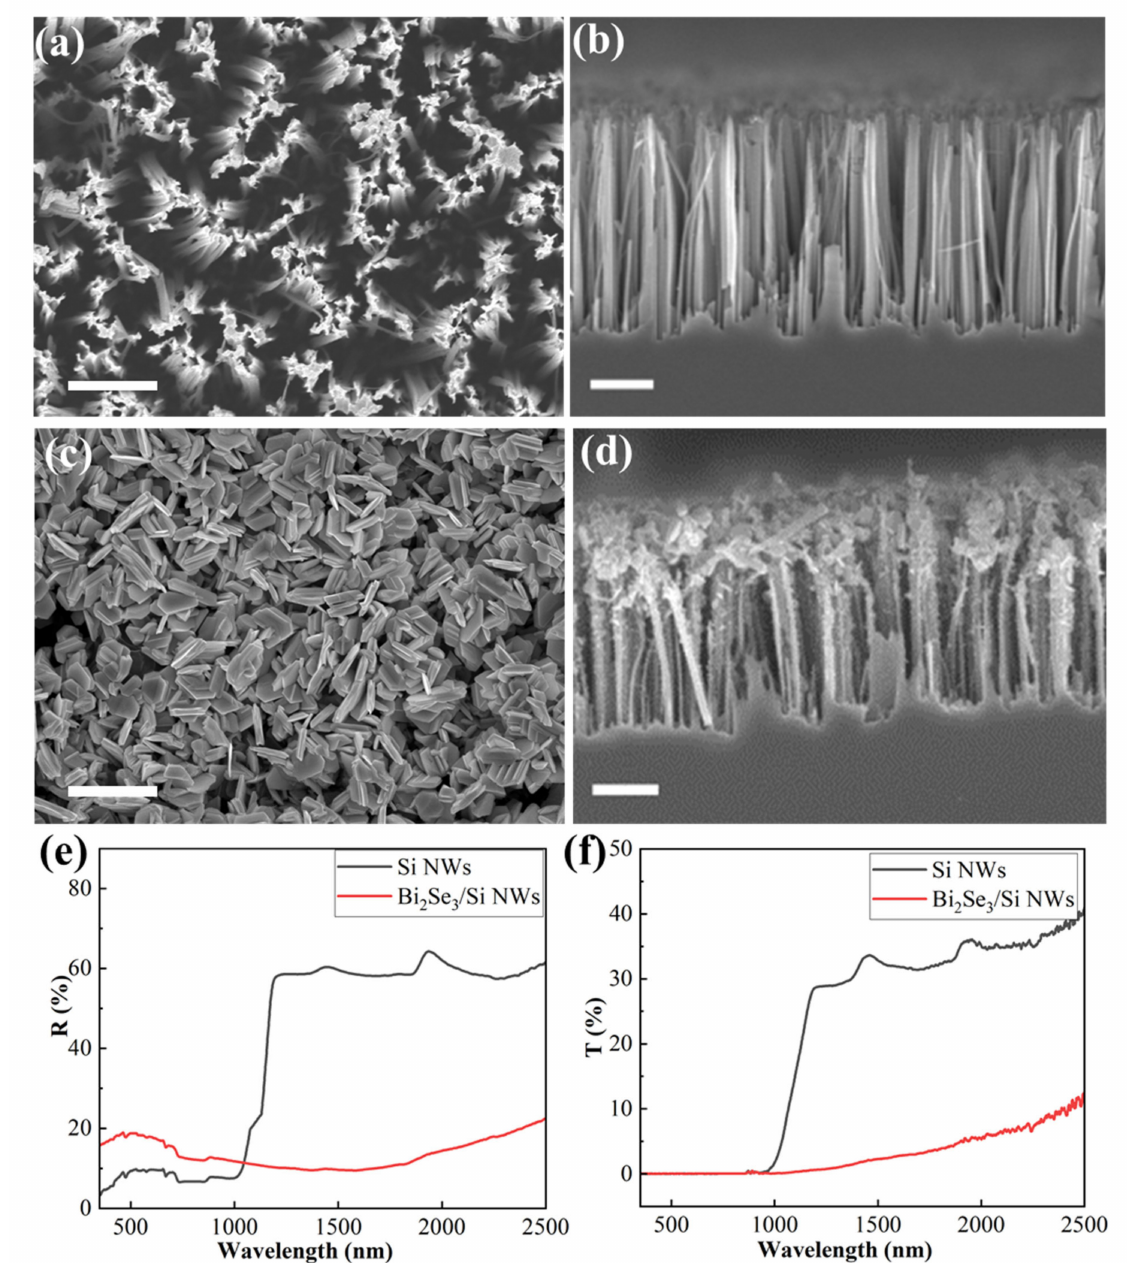
Figure 4. ( a ) Surface and ( b ) cross-section SEM images of Si NWs with the deposition time of 60 s for Ag NPs and the etching time of 10 min; ( c ) surface and ( d ) cross-section SEM images of Bi 2 Se 3 /Si NWs heterojunction with the deposition time of 60 s for Ag NPs and the etching time of 10 min; ( e ) reflectance and ( f ) transmittance of Si NWs and Bi 2 Se 3 /Si NWs samples. Scale bars in ( a – d ) are all 1 µ